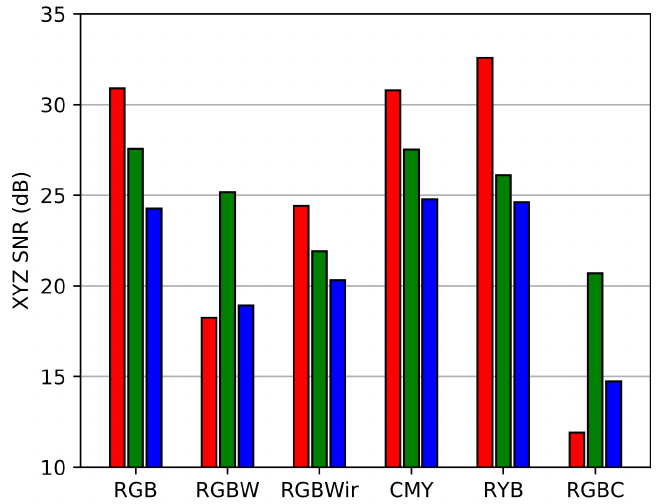
Figure 20. SNR over color components of each